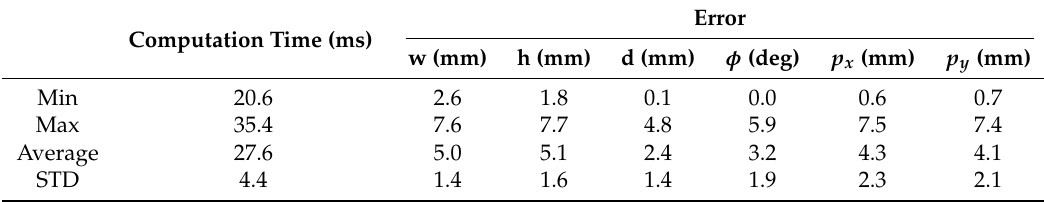
Table 1. The computation time and error of the proposed